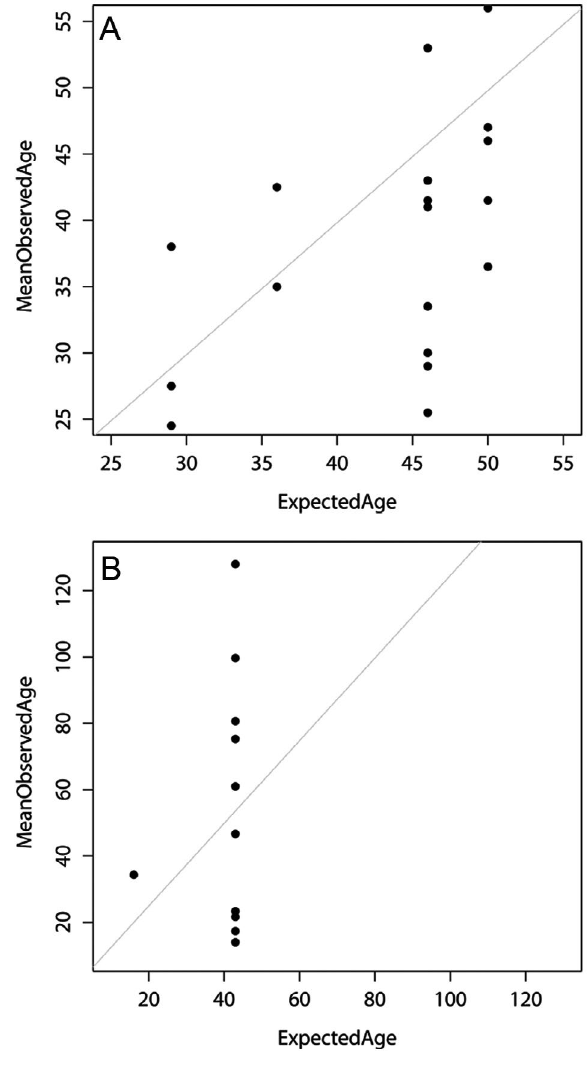
Fig. 2. – Relationship of the mean number of daily growth increments laid down after marking (two observations) and the expected (elapsed) days for A. minuta (A) and P. ferreri (B). Grey line represents slope relationship. Note that for P. ferreri several mean observations are coincident (in 23 and 46 observed days) and black dots are